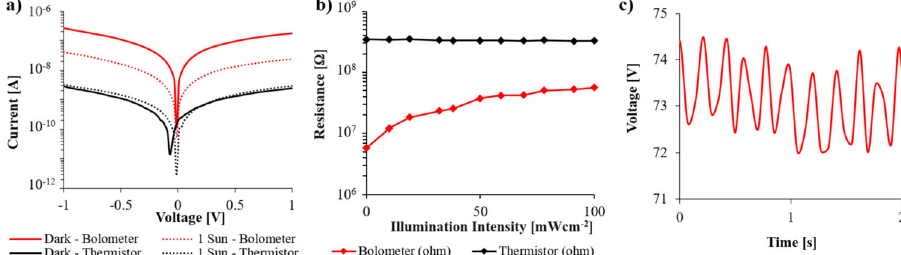
Fig. 4 Light-dependent characteristics of the printed thermistor and bolometer devices. a I – V characteristics of the P = 50 µm thermistor and bolometer devices under dark and 1 sun AM1.5 illuminated conditions. b Resistance of the P = 50 µm thermistor and bolometer devices under varying AM1.5 illumination intensities ( I b = 1 μ A). c Transient voltage response of P = 50 µm bolometer device under 1 sun AM1.5 illumination modulated at 5 Hz ( I b = 1 μ A).